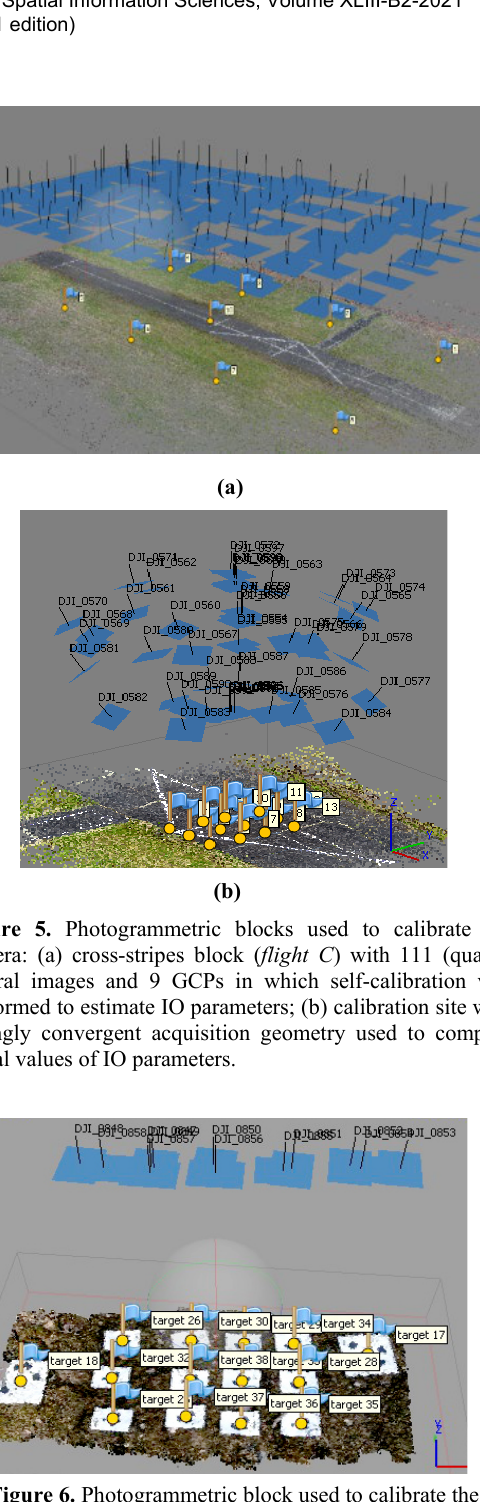
Figure 6. Photogrammetric block used to calibrate the level arm offset between the camera and GNSS antenna.